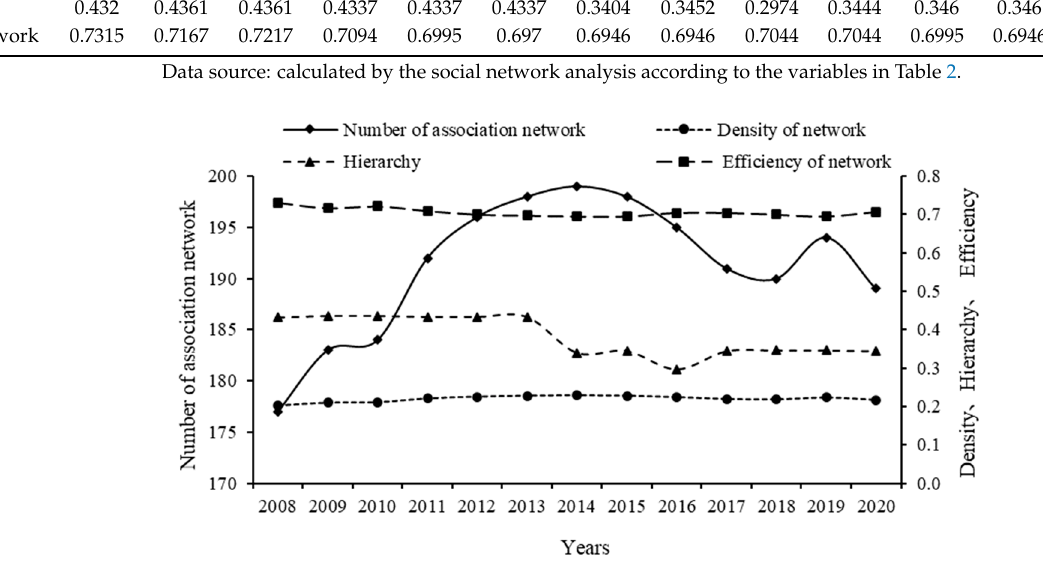
Figure 7. Overall structural trends of regional ESDE in China. Data source: Table 5.